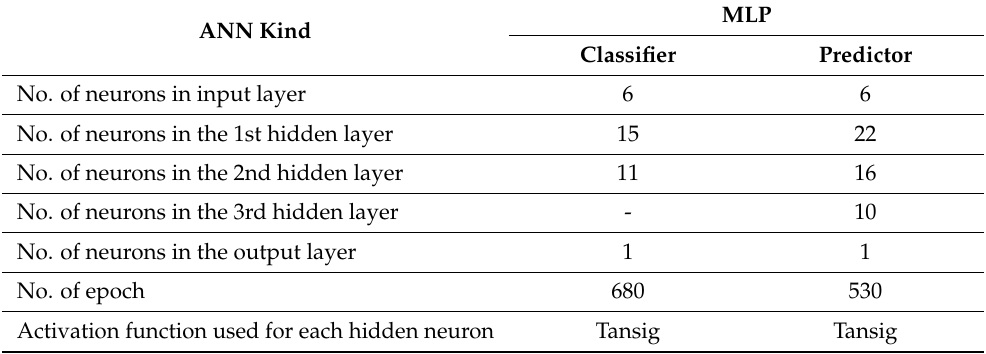
Figure 7. Structure of predictor network. Table 1. The characteristics of designed networks.